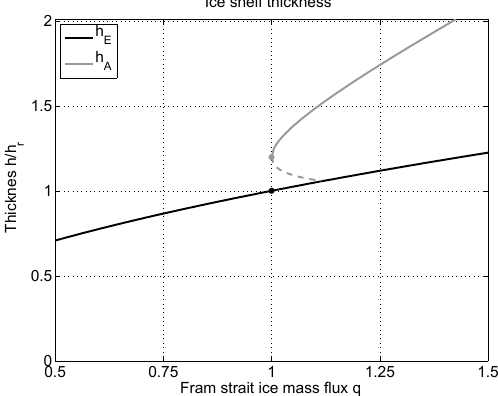
Figure 8. A conceptual illustration of how the steady-state ice-shelf thickness varies with the Fram Strait ice export, which equals the net accumulation over the ice shelf. The Amerasian Basin ice-shelf thickness h A is obtained from Eq. (36). The ice thicknesses are non- dimensionalized with the Lomonosov Ridge crest flotation thick- ness h r and the ice export is normalized to be unity when the shelf grounds on the ridge. When q < 1, the ice shelf is ungrounded and it has a single thickness over the Arctic Ocean. When the ice shelf grounds on the ridge, an ice-shelf thickness difference develops be- tween the Amerasian and Eurasian basins. The dotted line depicts a hypothetical solution with both grounding lines on the upstream side of the ridge, which presumably is